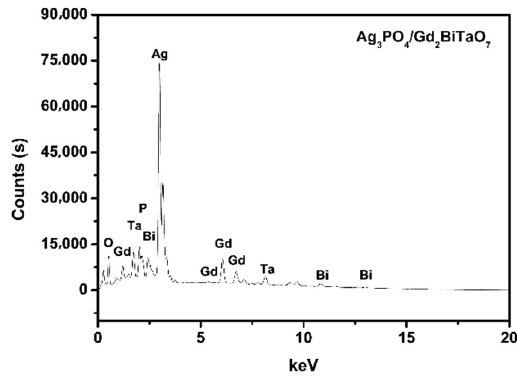
Figure 24. SEM photograph of Ag 3 PO 4 /Gd 2 BiTaO 7 heterojunction photocatalyst.